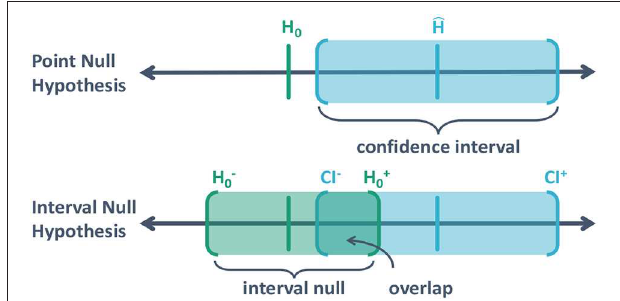
FIGURE 1 | Illustration of a point null hypothesis, H 0 ; the estimated effect that is the best supported hypothesis, ˆ H ; the a confidence interval (CI) for the estimated effect [ CI − , CI + ] ; and the interval null hypothesis